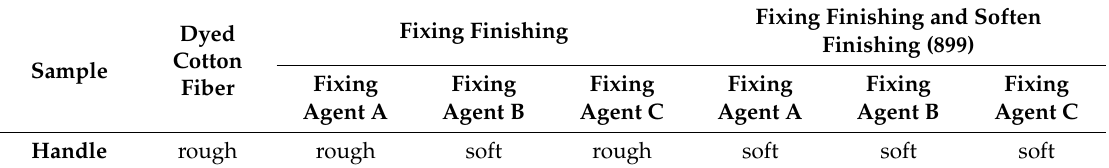
Table 3. The handle of the cotton fiber after fixing finishing and soften finishing.